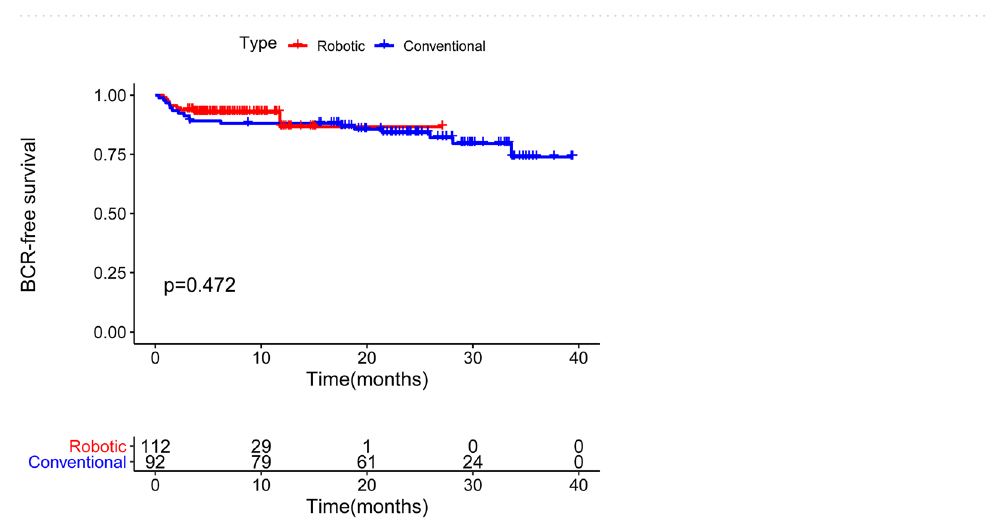
Figure 4. Comparison of postoperative health-related quality of life in patients with R-LESS-RP to those underwent C-LESS-RP (( A ) mobility; ( B ) self-care; ( C ) usual activity; ( D ) pain; ( E ) anxiety; ( F ) self-perceived health state). According to t-test or Mann–Whitney test.